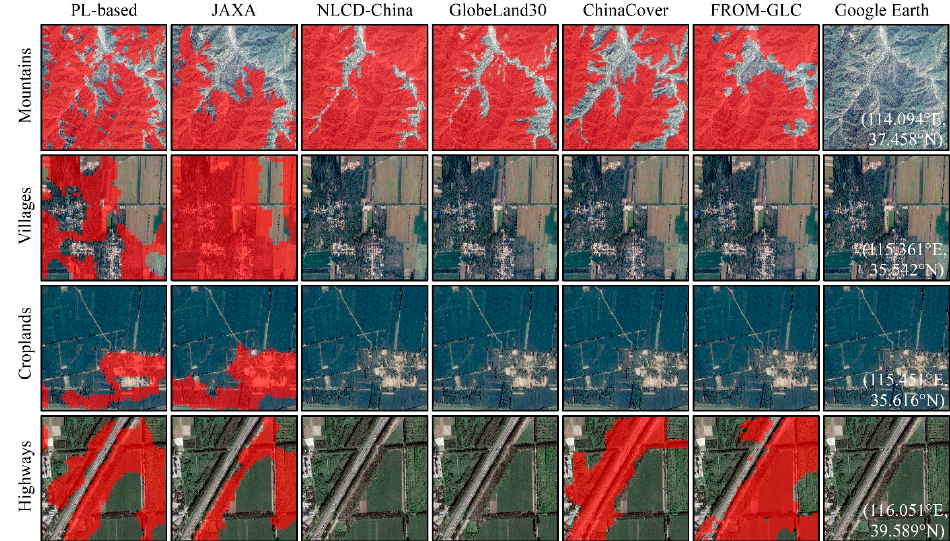
Figure 6. A zoom-in comparison between the PL-based and the other five forest maps in randomly selected landscapes of mountains, villages, croplands, and highways. selected landscapes of mountains, villages, croplands, and